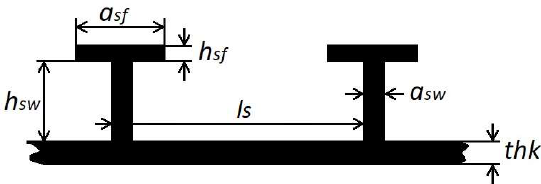
Figure 3. Framing system. l s , frames span. h sw , web height. a sw , web thickness. h sf , flange thickness. a sf , flange width. thk pressure hull wall